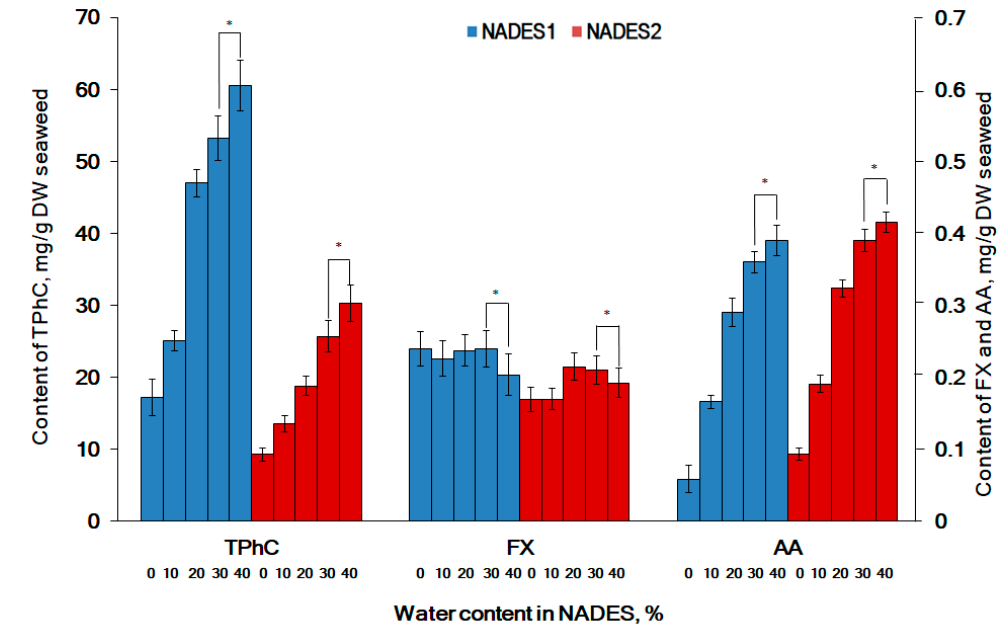
Figure 2. The effect of water content in NADES on the extraction efficacy of total phlorotannins (TPhC), fucoxanthin (FX), and ascorbic acid (AA) from F. vesiculosus . All experiments were performed using UAE at a 1:10 ( w / v ) seaweed to solvent ratio at 25 °C for 20 min. Water content 0, 10, 20, 30, and 40% ( v / v ). * The difference is not statistically significant, p > 0.05.